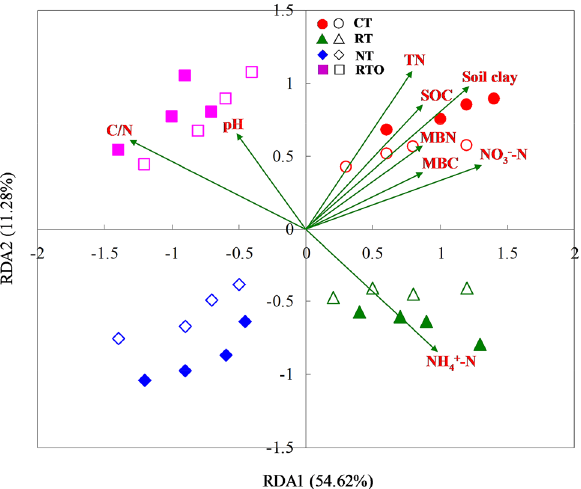
Figure 4. Redundancy analysis of soil microbial carbon source utilization rate and soil chemical properties. CT conventional tillage with crop residue incorporation, RT rotary tillage with crop residue incorporation, NT no-tillage with crop residue retention, RTO rotary tillage with crop residue removed as control. Solid icon and hollow icon were indicated rhizosphere and non-rhizosphere soils, respectively. SOC soil organic carbon, TN soil total nitrogen, MBC soil microbial biomass carbon, MBN soil microbial biomass